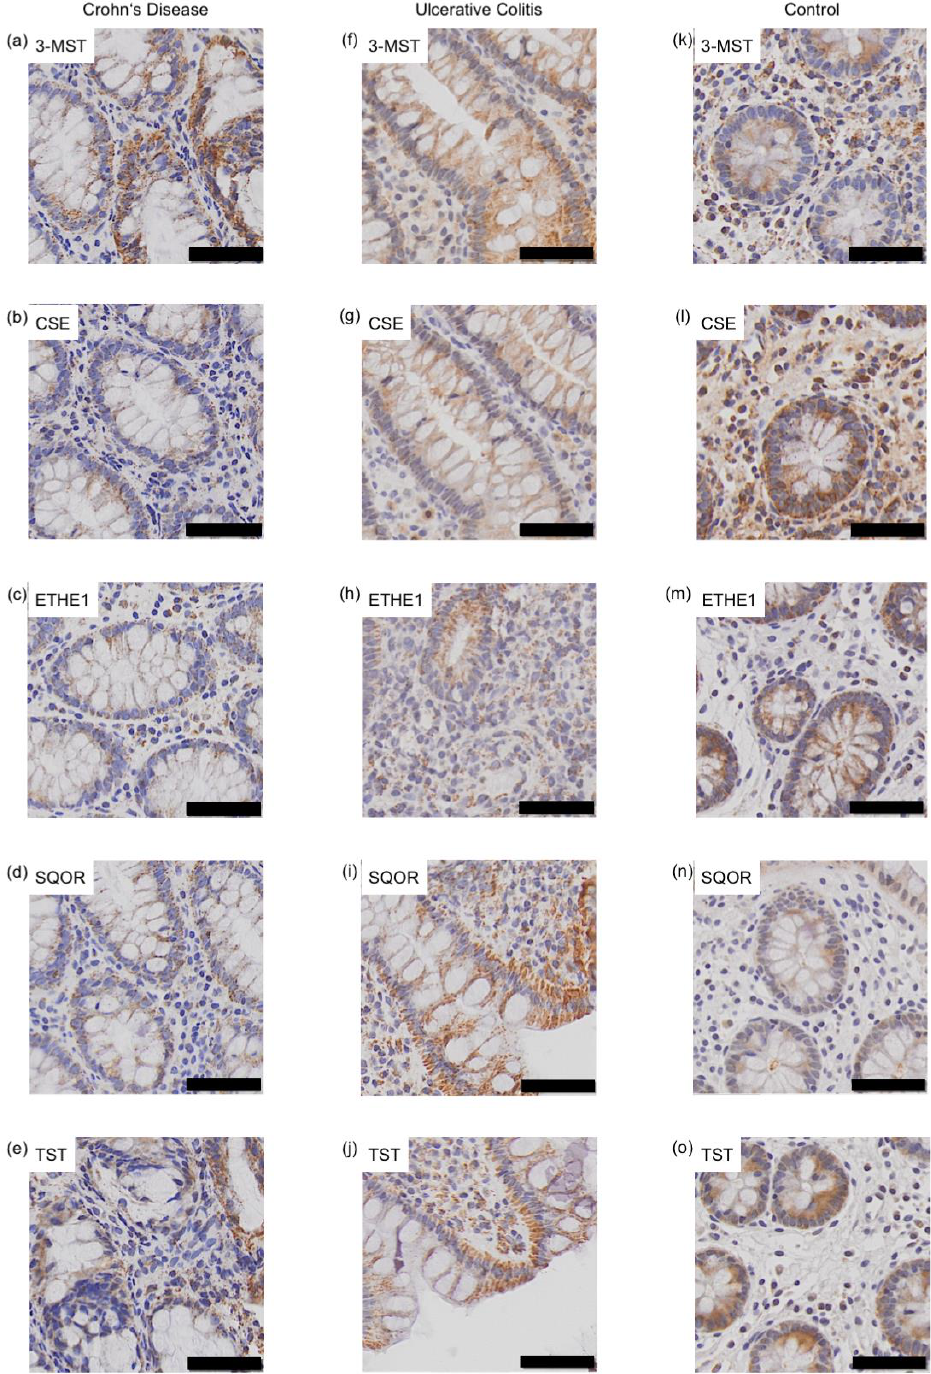
Figure 6. Immunohistochemical staining of 3-mercapto-sulfurtransferase (3-MST) ( a , f , k ), cystathionine- γ -lyase (CSE) ( b , g , l ), ethylmalonic encephalopathy 1 protein (ETHE1) ( c , h , m ), sulfide:quinone oxidoreductase (SQOR) ( d , i , n ) and thiosulfate sulfurtransferase (TST) ( e , j , o ) in the ascending colon of an pediatric Crohn’s disease (CD) patient (case number: 21480; a – e ), ulcerative colitis (UC) patient (case number: 17921; f – j ) and a healthy control (case number: 41952; k – o ). Scale bar: 50 μ m.